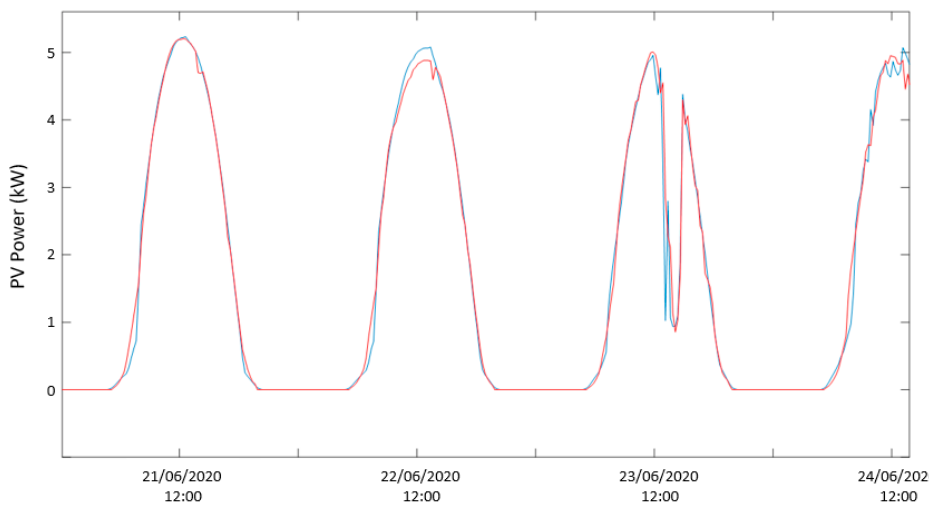
Figure 12. Measured (blue) and one-step-ahead forecast (red) DC PV power for four selected days. As is possible to see in Figure 11, the predicted values are very similar to the measured The results obtained were considered excellent, which did not justify using a second values in most points, with the most noticeable difference in a valley presented in the MOGA execution or the use of a model ensemble. third